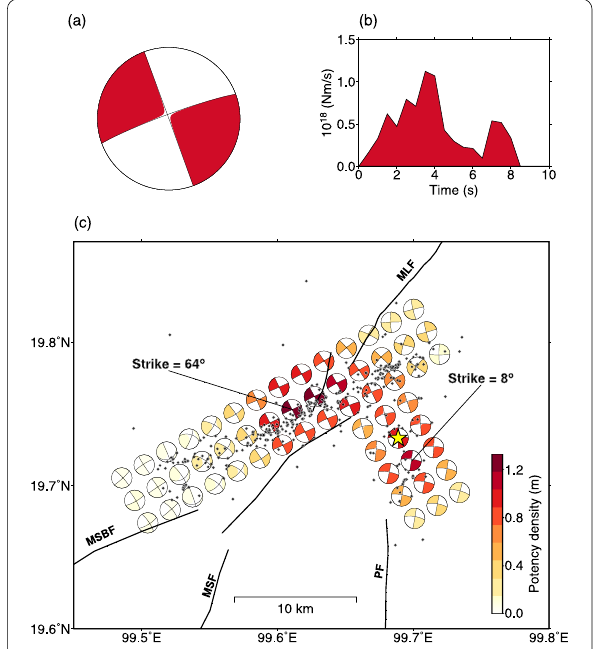
Fig. 6 The summary of the result. a The total moment tensor solution. b The moment rate function. c The focal mechanism distribution of the potency density tensor of each sub-fault along the assumed horizontal model plane. The color shows the amount of potency density. The yellow star denotes the epicenter. The dots are the relocated aftershocks (Pananont et al. 2017). The black solid lines are the active faults (DMR 2016; Kanthiya et al. 2019): MLF: Mae Lao fault, PF; Phan fault, MSF; Mae Suai fault, MSBF; Mae Suai Boundary fault